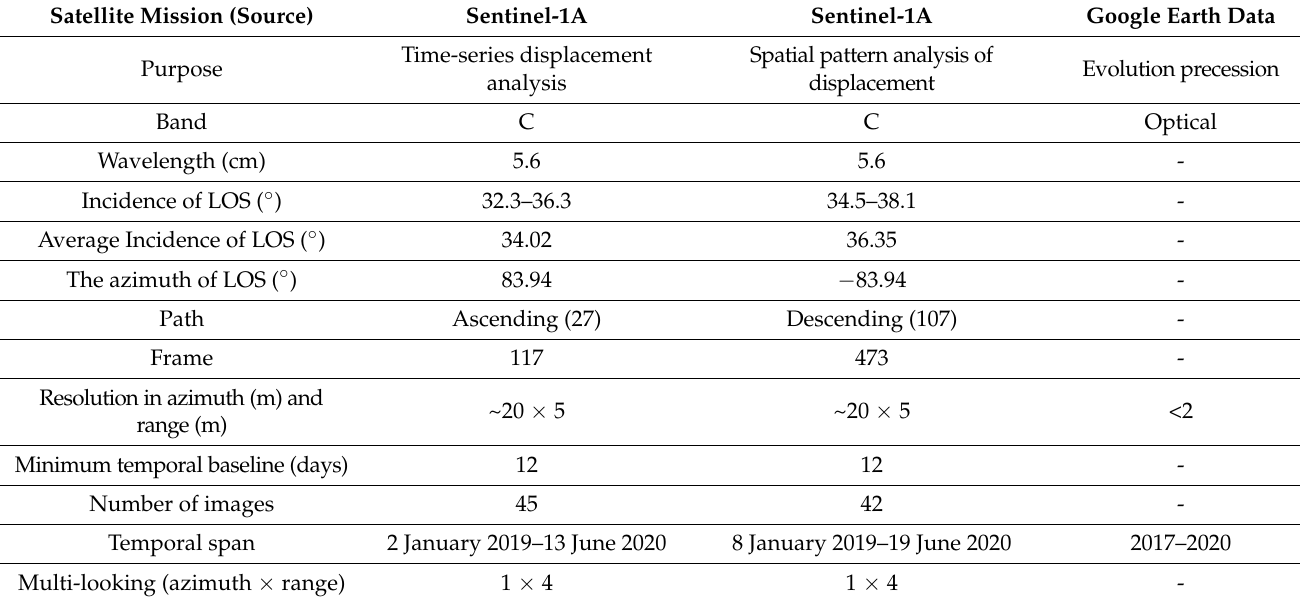
Table 1. Basic parameters of optical images and SAR datasets in this study.